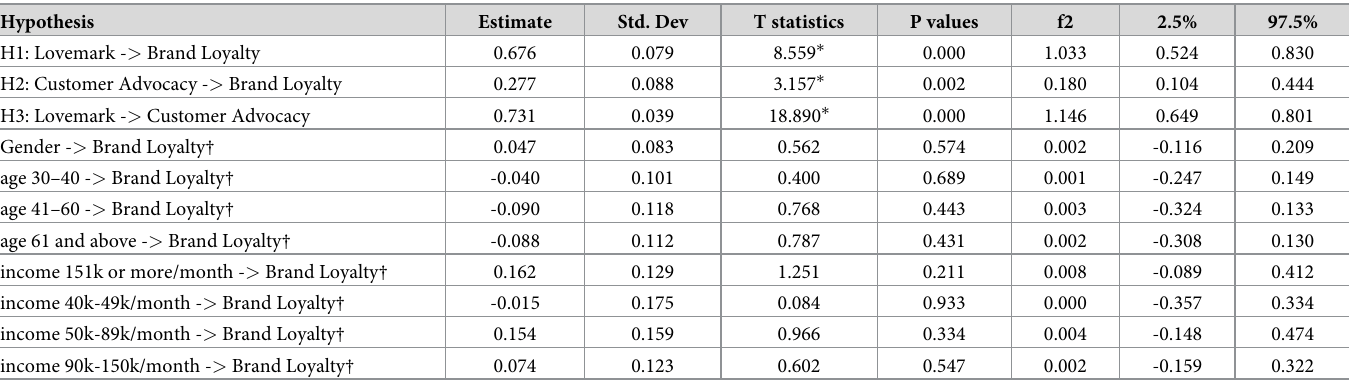
Table 4. Hypothesis testing